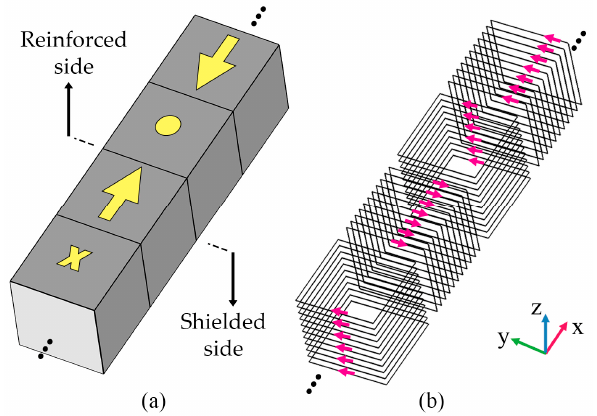
Figure 2. ( a ) A typical linear Halbach array in which the magnetization vectors are noted and ( b ) its coil-based equivalent.